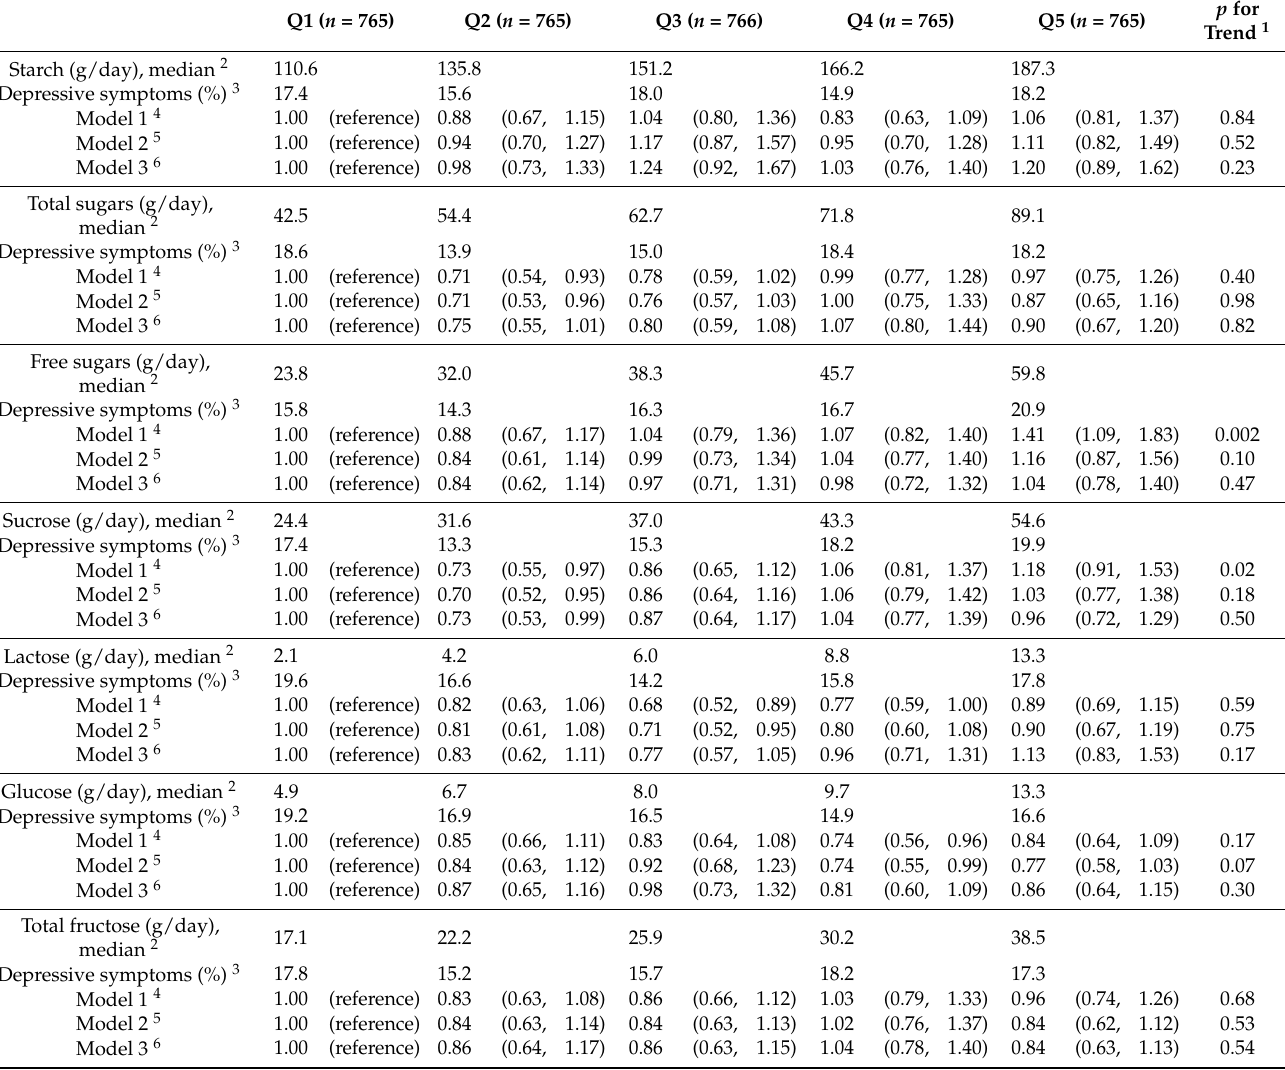
Table 6. Odds ratios (95% confidence intervals) for depressive symptoms according to the quintiles of the energy-adjusted intakes of starch and sugars in 3826 middle-aged Japanese